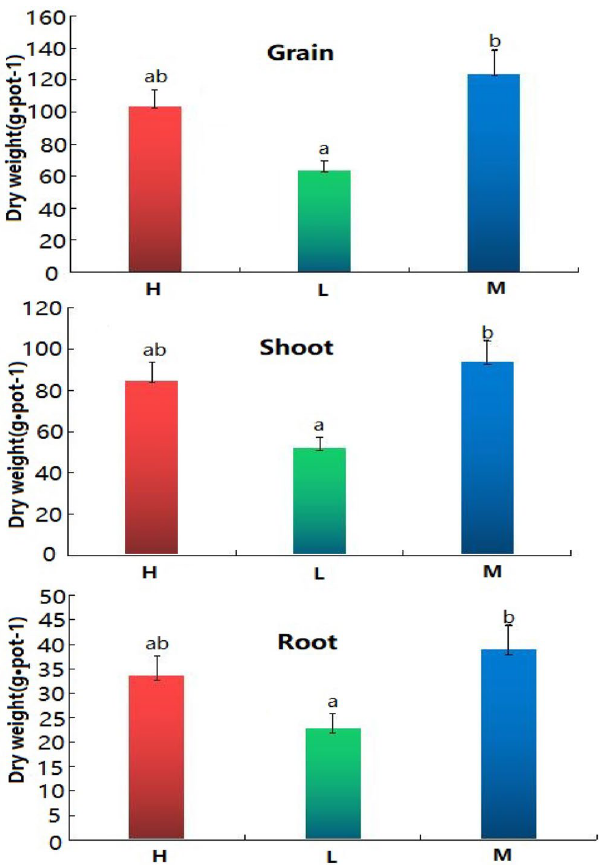
Figure 2. Dry weight of grain, shoot and root of rice. Different letters indicate significant differences between potted rice in different